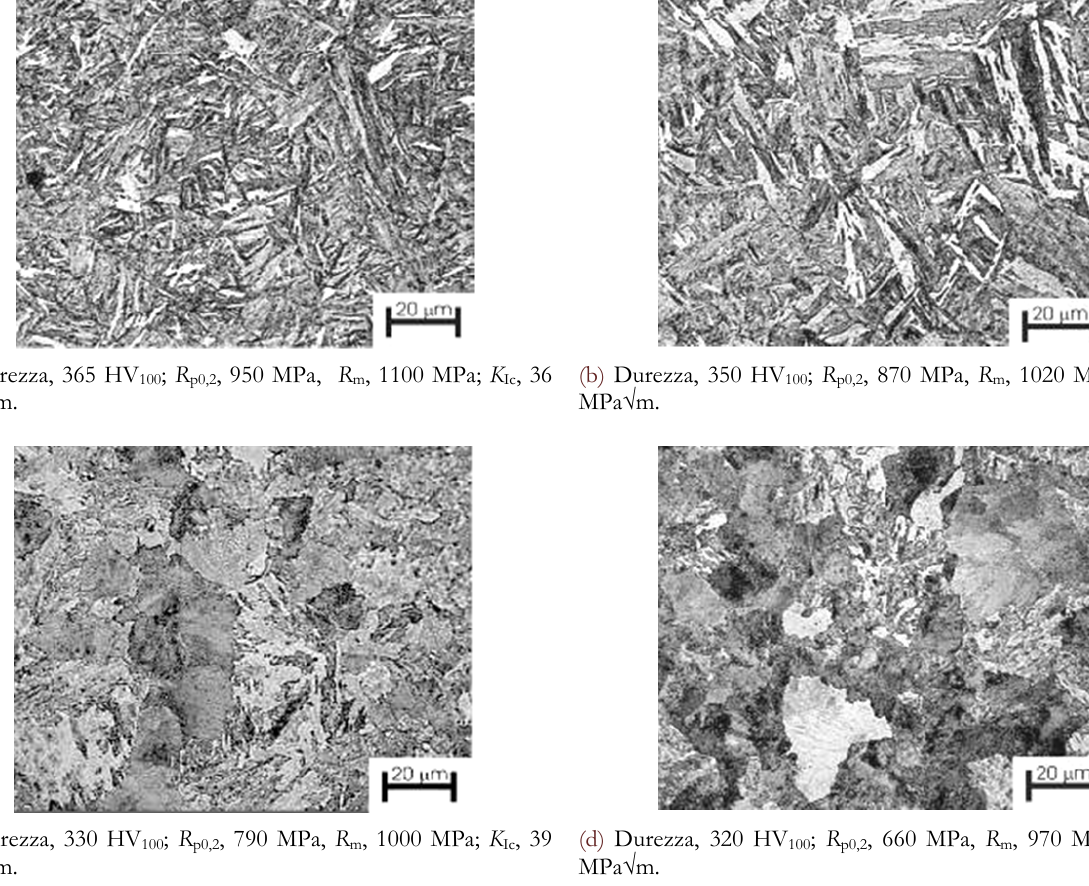
Figura 2: Costituenti metallografici e caratteristiche meccaniche in un acciaio 40CrMnNiMo8-6-4, temprato e rinvenuto ad ottenere microstrutture miste; attacco Nital. (a) martensite rinvenuta, austenite residua trasformata durante il rinvenimento; (b) bainite inferiore modificata dal rinvenimento, austenite residua trasformata durante il rinvenimento; (c) perlite fine ed ultra-fine, bainite superiore modificata dal rinvenimento; (d) perlite fine, bainite superiore modificata dal rinvenimento (caratterizzata da carburi ingrossati). Figure 2: Metallographic constituents and mechanical properties in a 40CrMnNiMo8-6-4 steel, quenched and tempered to yield mixed microstructures; Nital etch. Tempered martensite with some residual austenite transformed during tempering (a); lower bainite modified by tempering, residual austenite transformed during tempering (b); fine and ultra-fine pearlite, upper bainite modified